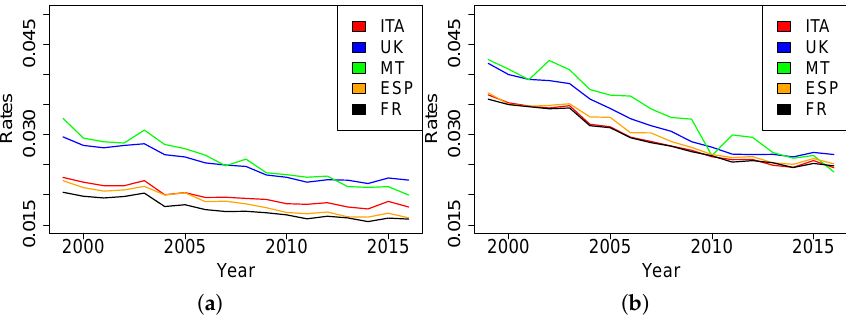
Figure 3. ( a ) female yearly standardized death rates, ( b ) male yearly standardized death